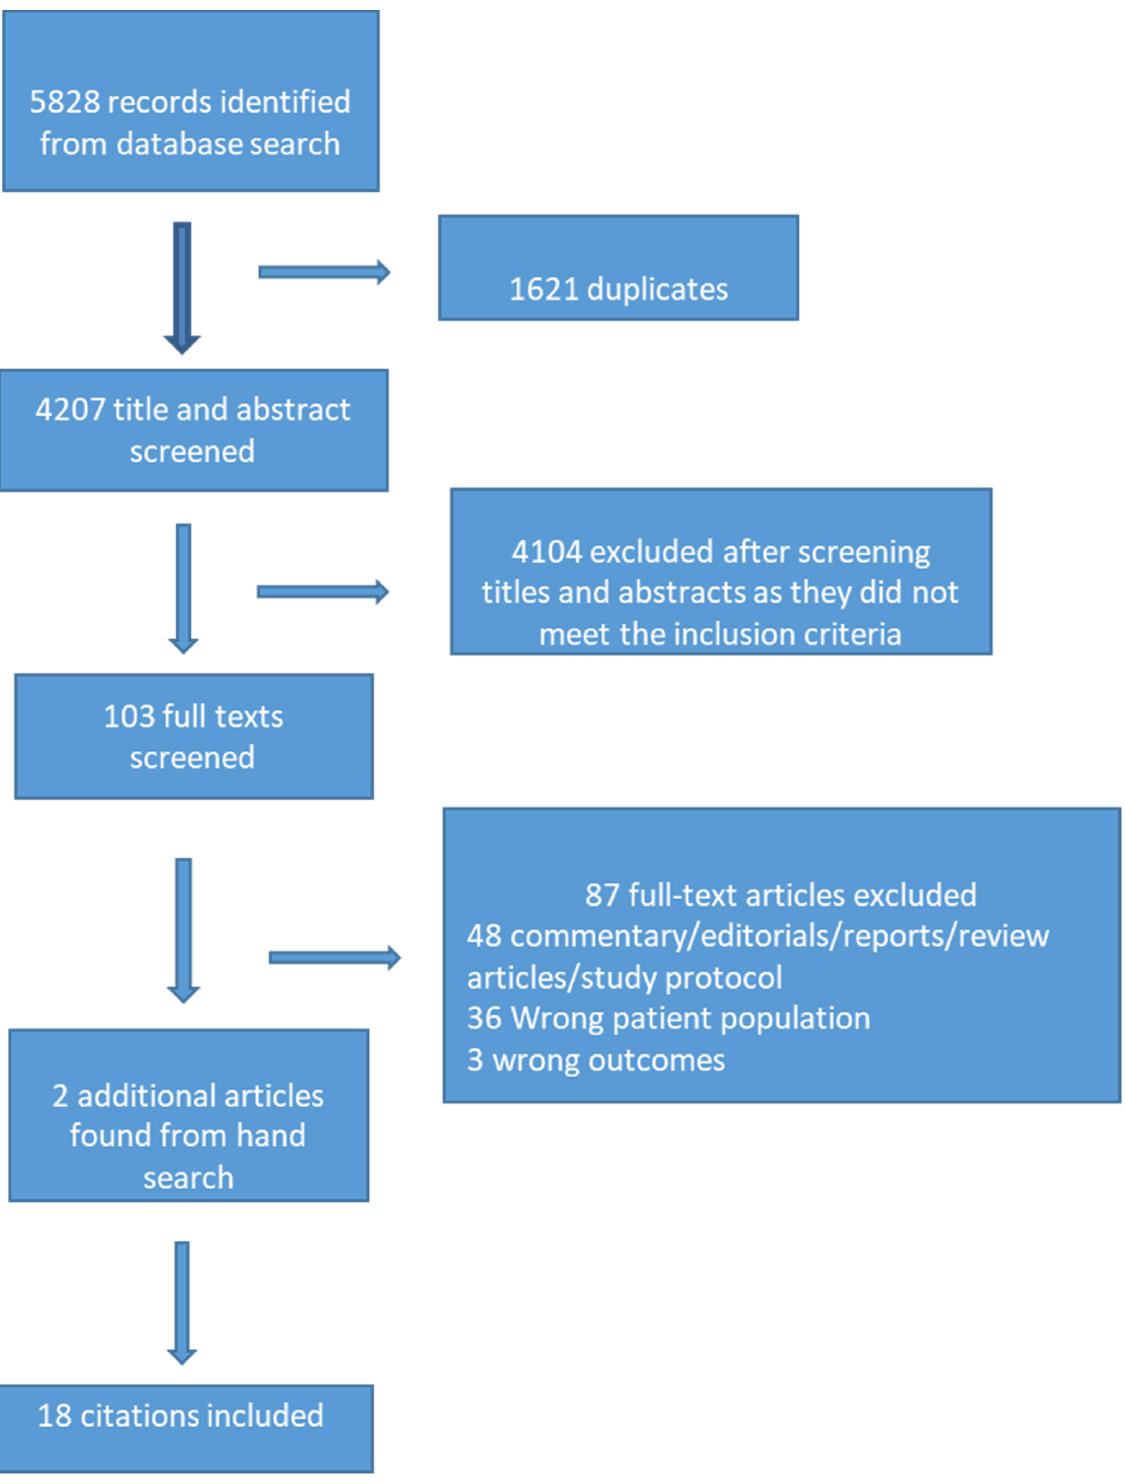
Figure 1. Preferred Reporting Items for Systematic Reviews and Meta-Analyses (PRISMA) dia- gram.